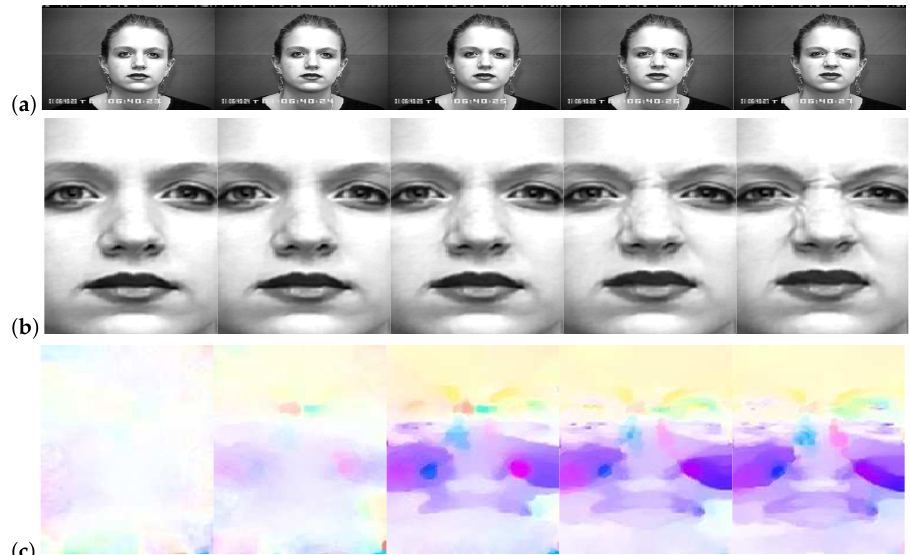
Figure 2. Face normalization and motion flow estimation. ( a ) Original input video sequences. ( b ) Normalized faces. ( c ) Estimated dense optical flow. Optical flow is color-coded by its direction and intensity as in